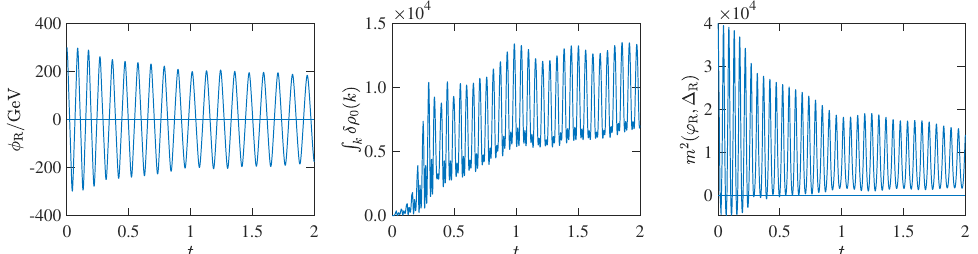
Figure 4 . Shown is the evolution of the classical field as a function of time (left), evolution of the integrated non-equilibrium part of the local correlation function (middle), and the effective mass function m 2 ( ϕ R , ∆ R ) (right). We used λ (4) = 1 , m R = 100 GeV, ϕ R , in = 300 GeV and ∂ t ϕ R , in = 0 . R The moment functions were initialized to the non-coherent vacuum values (4.8). We also assumed no friction, setting c i to